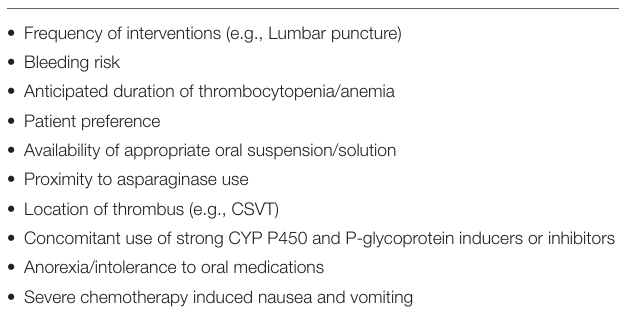
TABLE 1 | Considerations for DOAC